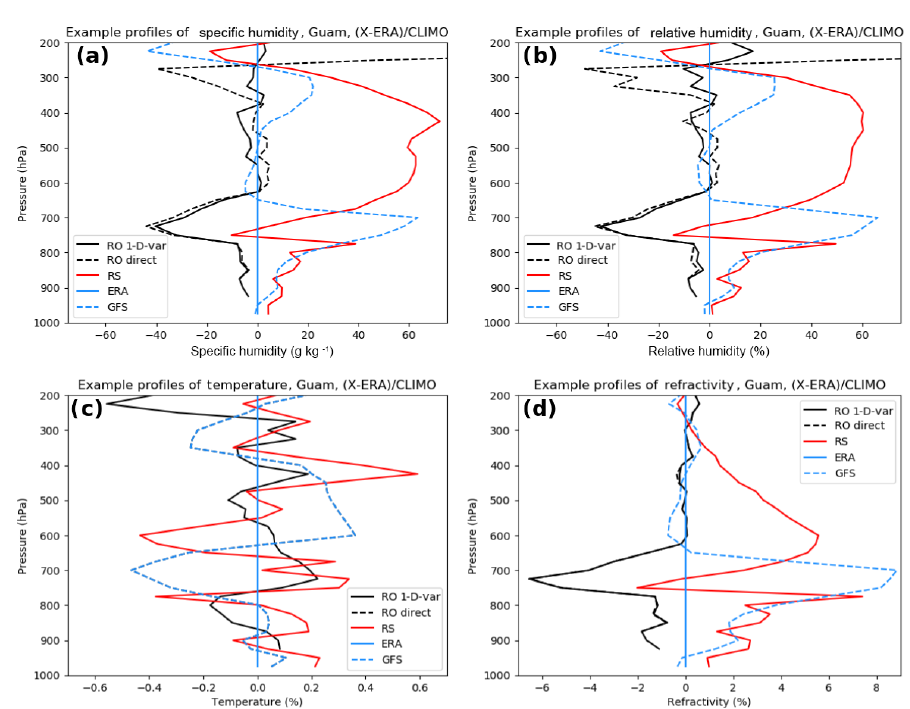
Figure 4. Same as Fig. 3 except for normalized differences from